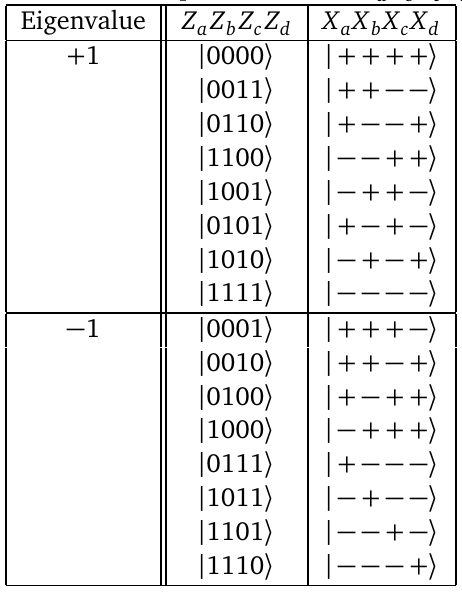
Table 2: Eigenstates for the four-qubit stabilizers Z